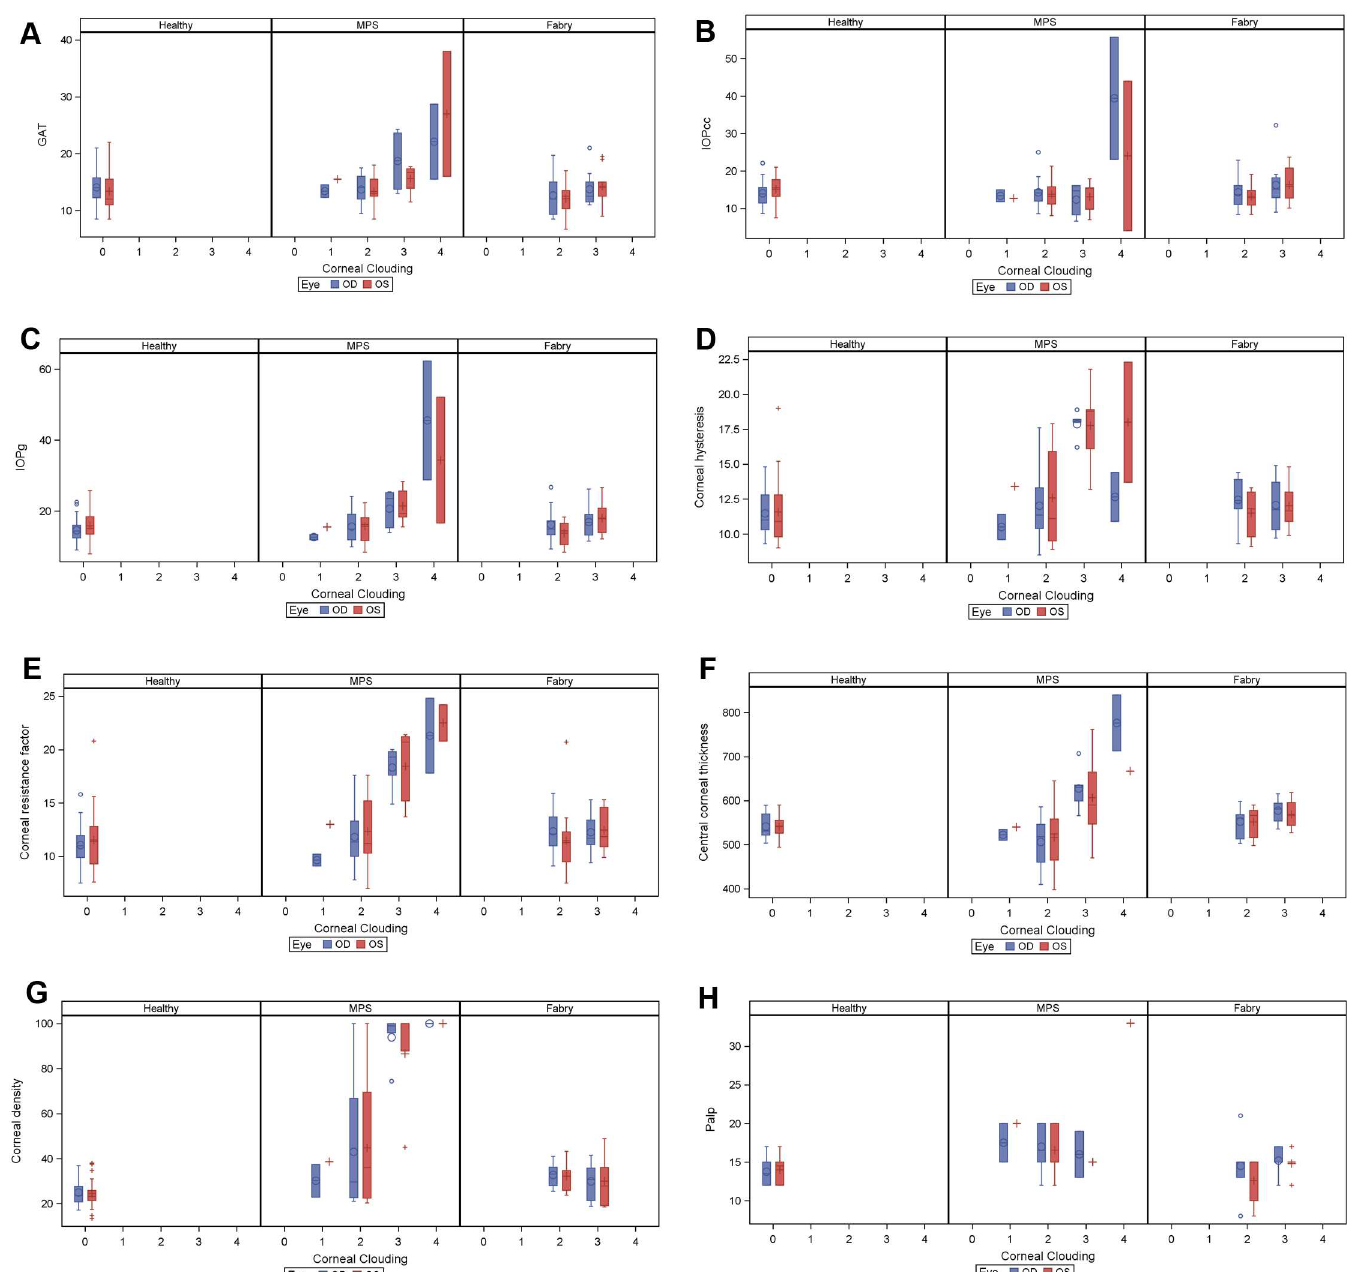
Fig 5. Association between Goldmann applanation tonometry (GAT), corneal compensated IOP (IOPcc), Goldmann correlated IOP (IOPg), corneal hysteresis (CH), corneal resistance factor (CRF) central corneal thickness (CCT), corneal density and the grade of corneal clouding in all experimental groups. Estimated means and 95% confidenceintervalsare